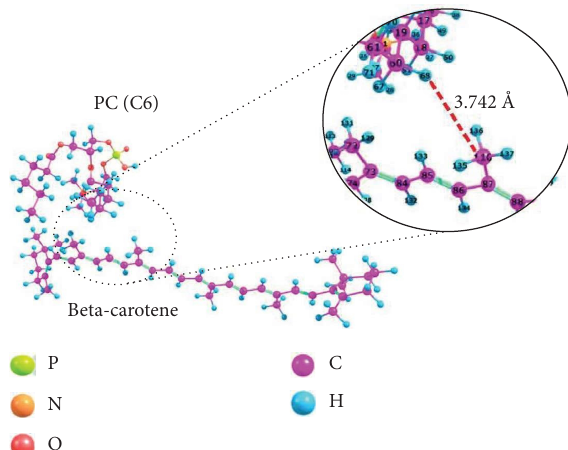
Figure 3: Te interaction of phospholipid and beta-carotene molecules using an optimized structure.